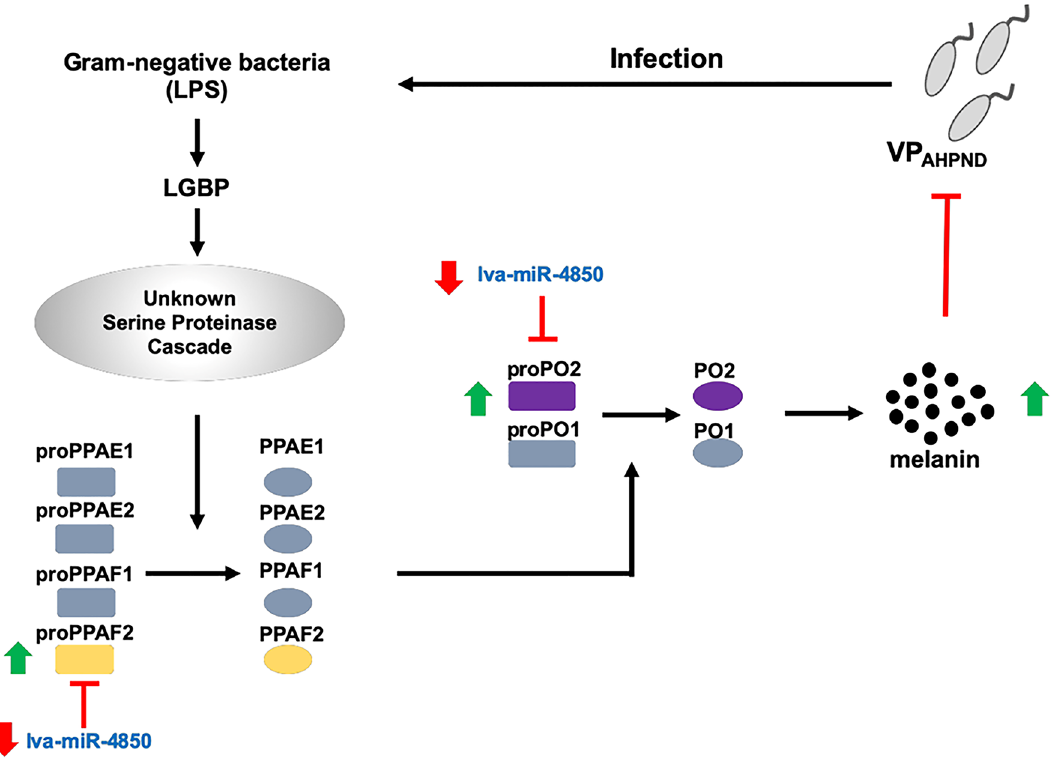
Figure 5. Schematic representation of how the lva-miR-4850 modulates the proPO system upon VP AHPND